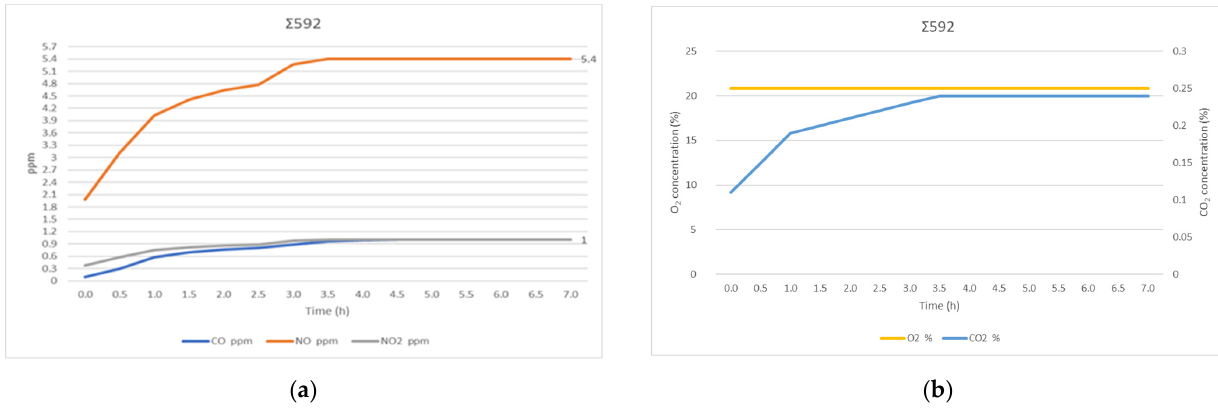
Figure 7. Results of a 7 h gas simulation at position Σ 592. ( a ) CO, NO and NO 2 in ppm; ( b ) O 2 and CO 2 expressed in